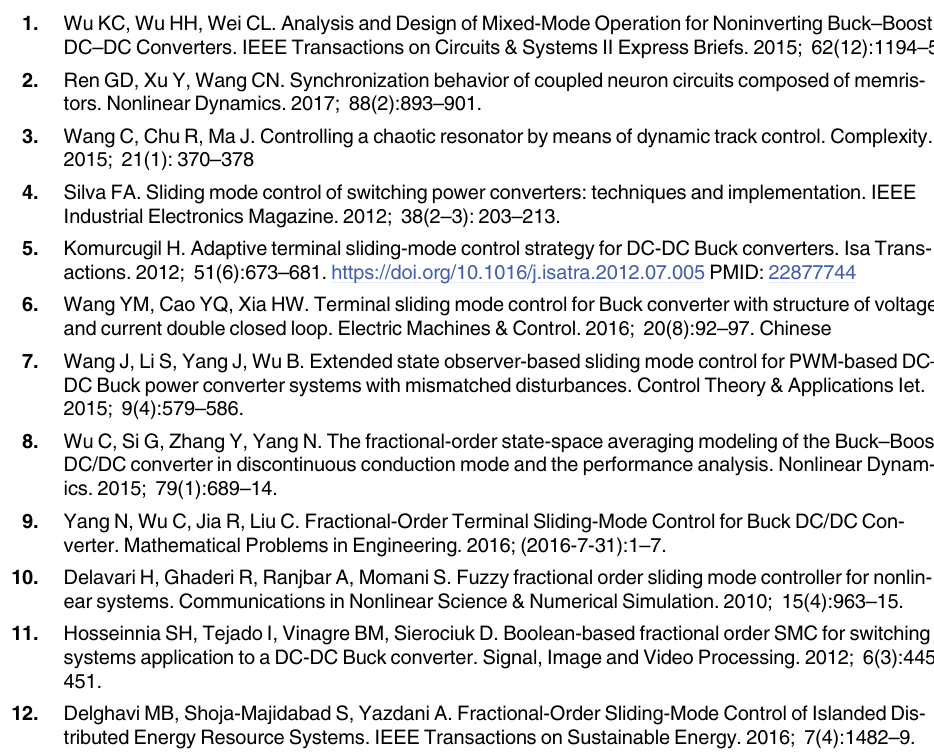
S1 Fig. Simulation framework diagram. In this simulation framework, the sliding surface function S could be the integer or fractional order terminal sliding surface function. S2 Fig. The output voltage dynamic response with different strategy. The control strategies include terminal sliding mode control (TSMC), adaptive terminal sliding mode control (ATSMC), and adaptive fractional order terminal sliding mode control (AFTSMC) respec-